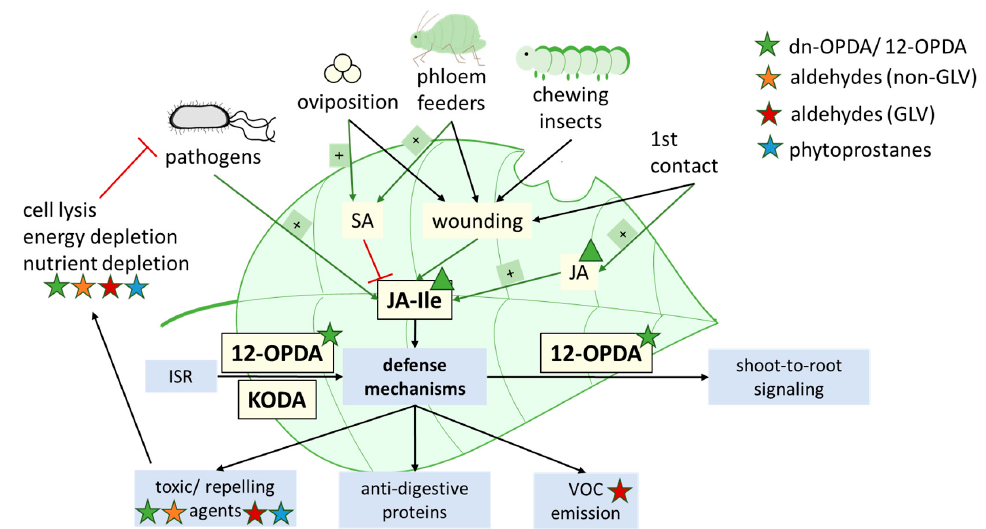
Figure 6. Oxylipins as main mediators of biotic stress (alongside SA). Besides JA, 12-OPDA, (non- GLV)-aldehydes, and phytoprostanes influence plant defense against pathogens and herbivory. Processes influenced by these oxylipins are indicated by colored stars. Functions fulfilled by (dn-) OPDA in the absence of JA are marked by triangles.